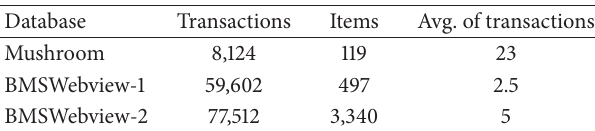
Table 6: Three databases.